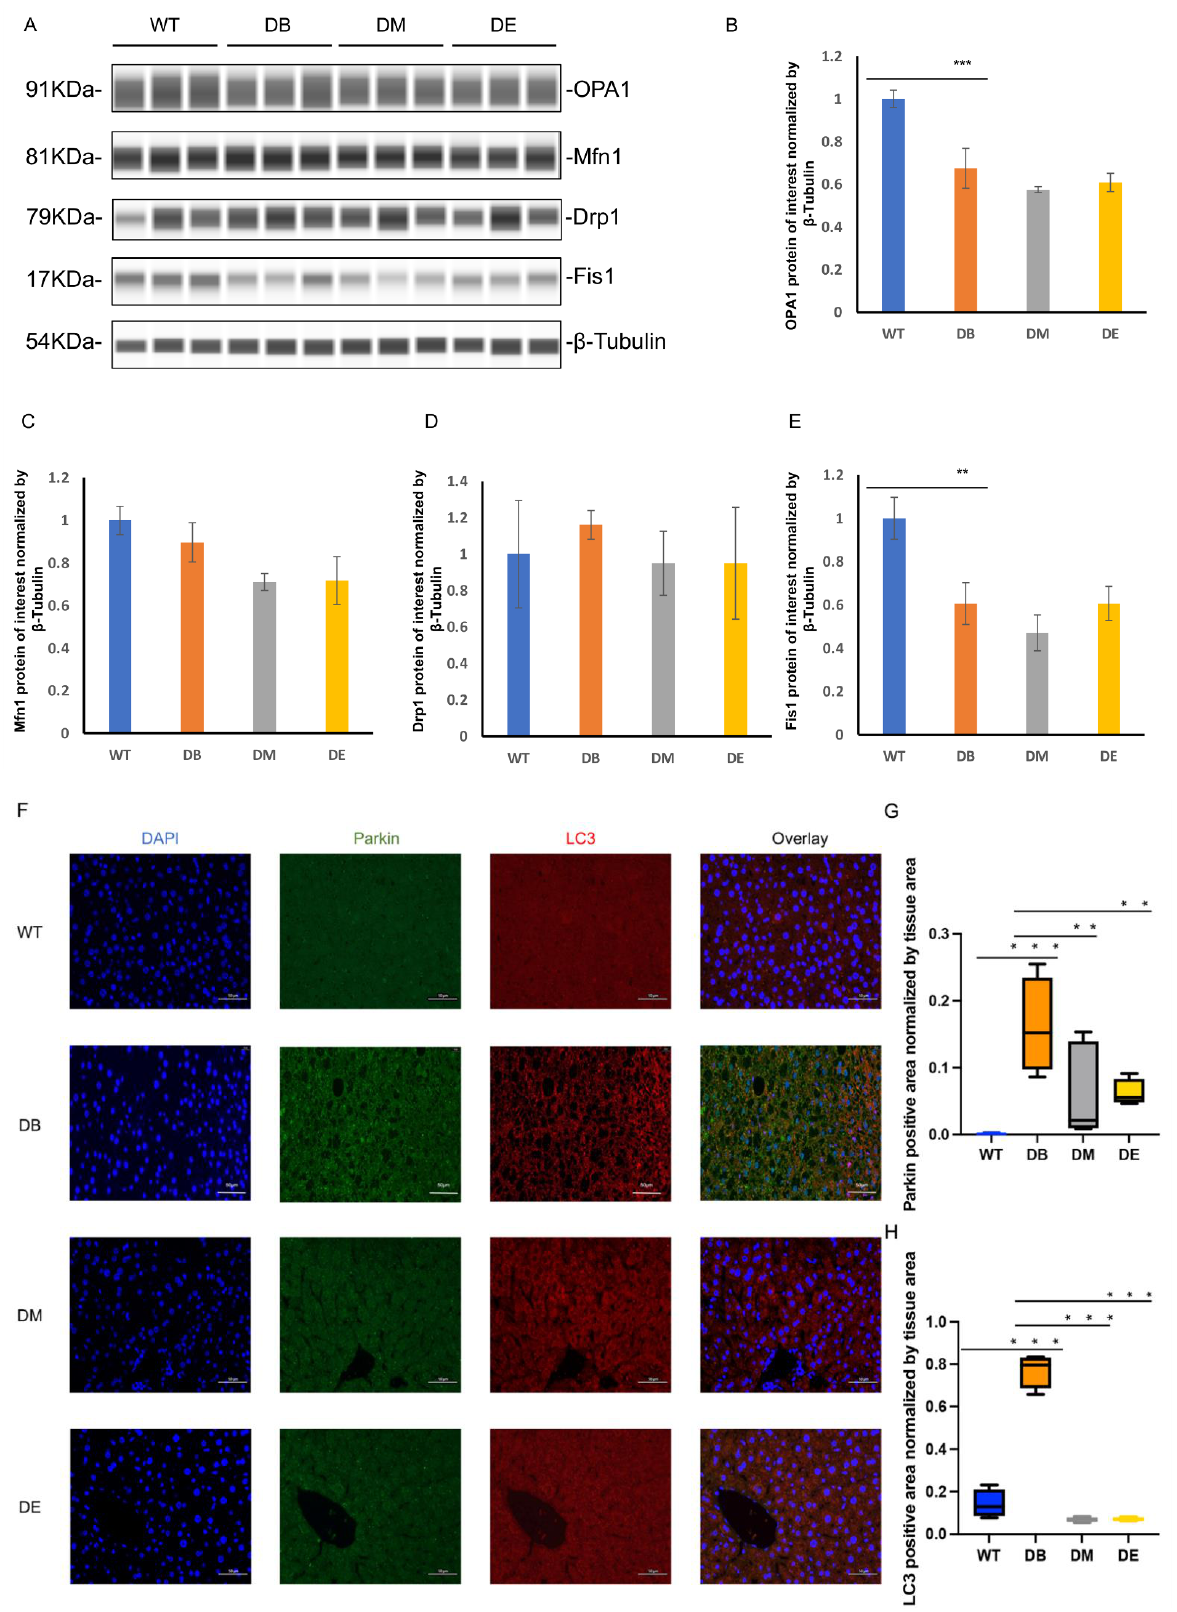
Figure 5. Diabetes dramatically impairs mitochondrial quality, and exercise ameliorates excessive mitophagy caused by diabetes. ( A ) Wes TM of OPA1, Mfn1, Drp1, and Fis1 expression in livers from WT, DB, DM, and DE mice. ( B ) Statistical evaluation of OPA1 expression in livers. *** p < 0.001, n = 3. ( C ) Statistical evaluation of Mfn1 expression in livers, n = 3 to 4. ( D ) Statistical evaluation of Drp1 expression in livers, n = 3. ( E ) Statistical evaluation of Fis1 expression in livers. ** p < 0.01, n = 3. ( F ) Representative images of Parkin and LC3 in livers from WT, DB, DM, and DE mice ( n = 3). ( G ) Statistical evaluation of Parkin of ( F ), ** p < 0.01 and *** p < 0.001. ( H ) Statistical evaluation of LC3 of ( F ), *** p < 0.001. Scale bar: 50 μm.